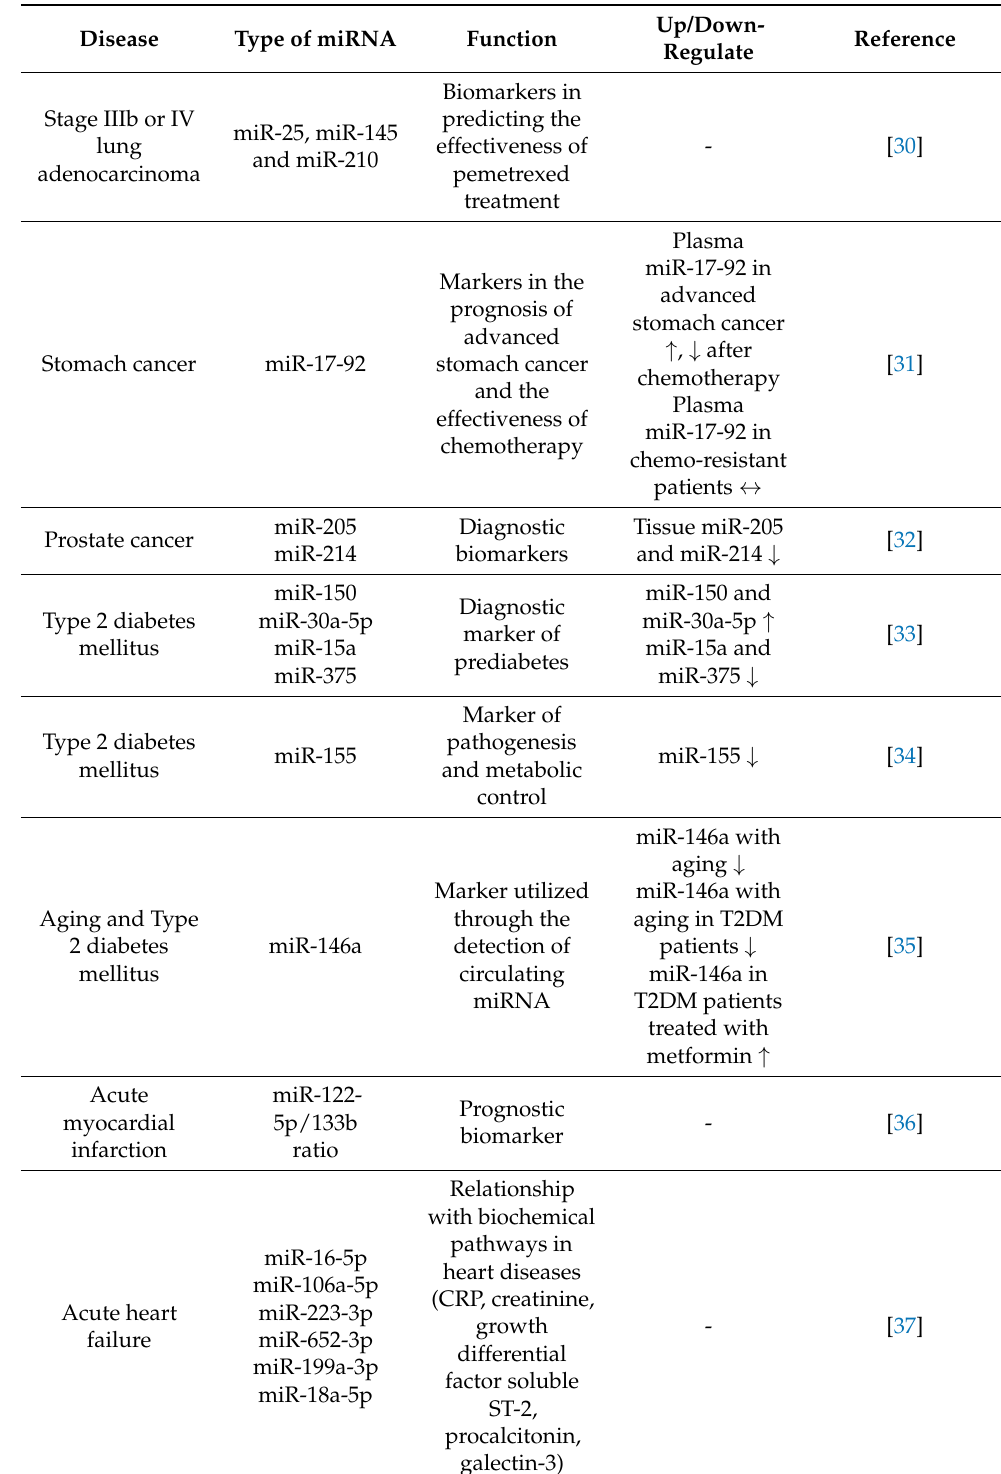
Table 1. miRNAs characterized as biomarkers in some non-infectious diseases and clinical conditions, their possible functions, and their effects on genetic